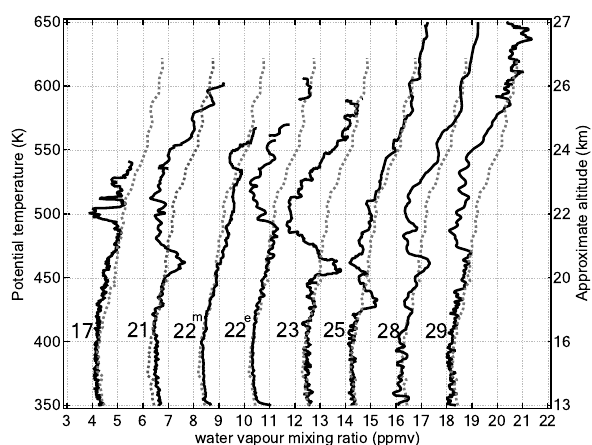
Fig. 2. Vertical profiles of water vapour obtained during January 2010 (solid black lines) compared against the “climatological” wa- ter vapour profile (based on January mean water vapour from FPH and CFH soundings at Sodankylä in 2002–2010, grey dashed lines). Successive profiles are shifted by 2ppmv. The dates of the sound- ings are given on the left of each profile. The superscript indices “m” and “e” indicate respectively morning and evening soundings on 22 January. The profiles of 17, 25, 28 and 29 January were ob- tained using FLASH-B, the remaining profiles were obtained using